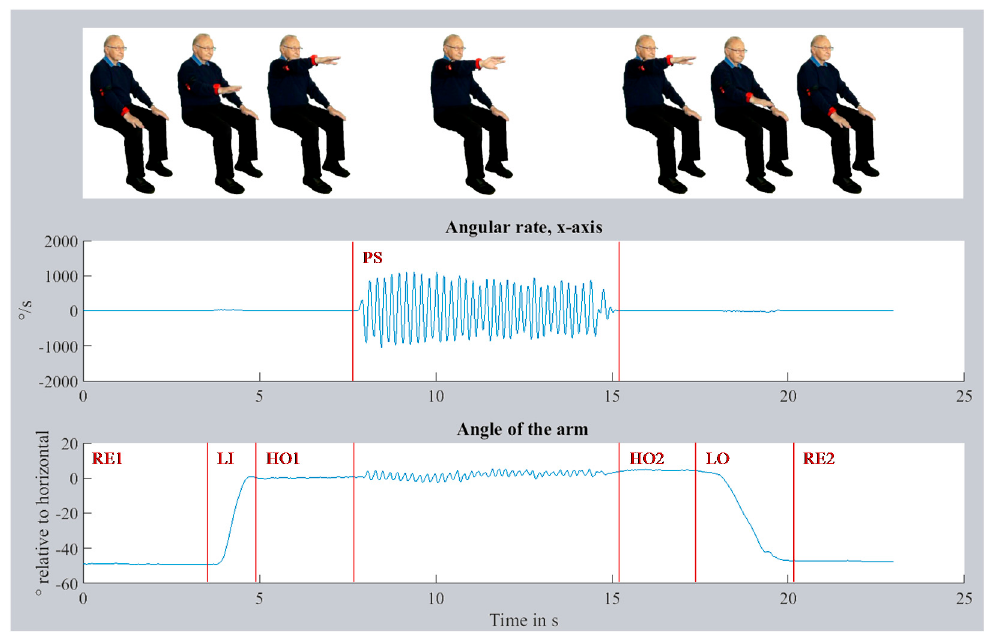
Figure 3. Visualization of the pronation-supination task and segmentation of the movement data.